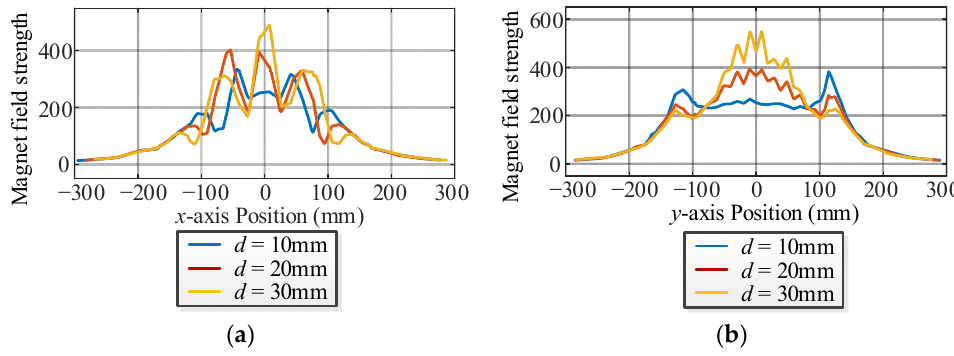
Figure 5. Magnet field strength waveforms with different distances. ( a ) x ‐ axis. ( b ) y ‐ axis.